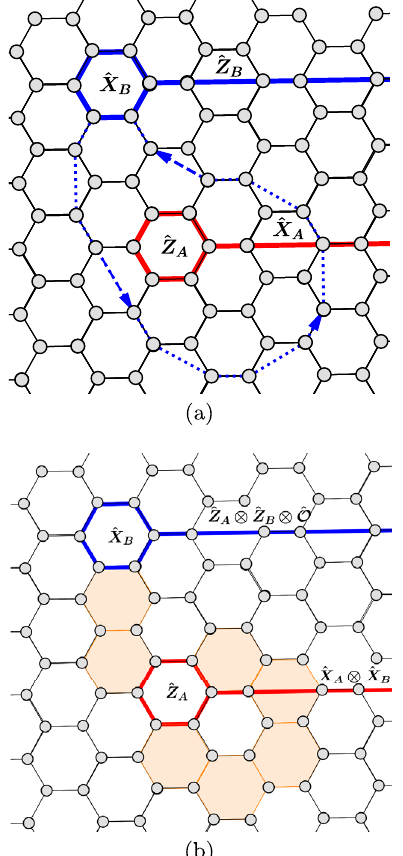
FIG. 9. Braiding processes that implement the transformation ˆ Z → ˆ Z ⊗ ˆ Z ⊗ ˆ Z ⊗ ˆ Z (a) up to an overall sign, as deter- a a c t out mined by the product of the appropriate plaquette operators ˆ Z ˆ Z → ˆ Z ⊗ ˆ Z → ˆ Z ⊗ ˆ Z enclosed by the path l , and (b) , , A t t A out out ˆ Z → ˆ Z ⊗ ˆ Z . The two braids are used to realize CNOT gates c c A between two (a) A -type and (b) B -type logical qubits,